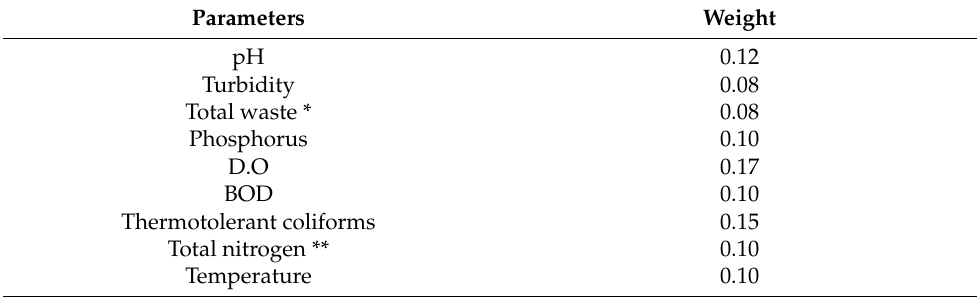
Table 2. Parameters used for WQI calculation and their weights.